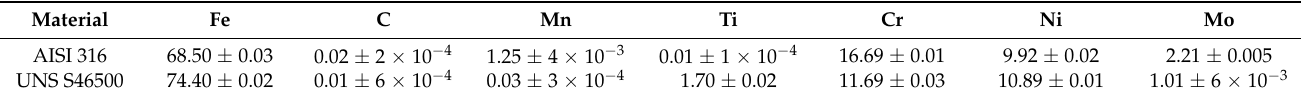
Table 1. Chemical composition of analyzed steels (in wt %).